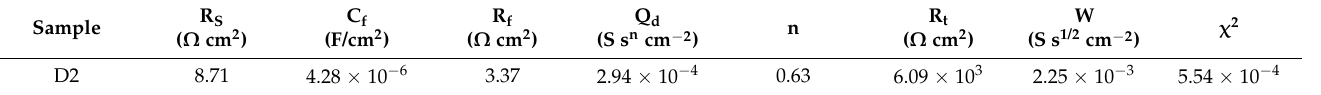
Table 4. Values of the equivalent circuit for sample